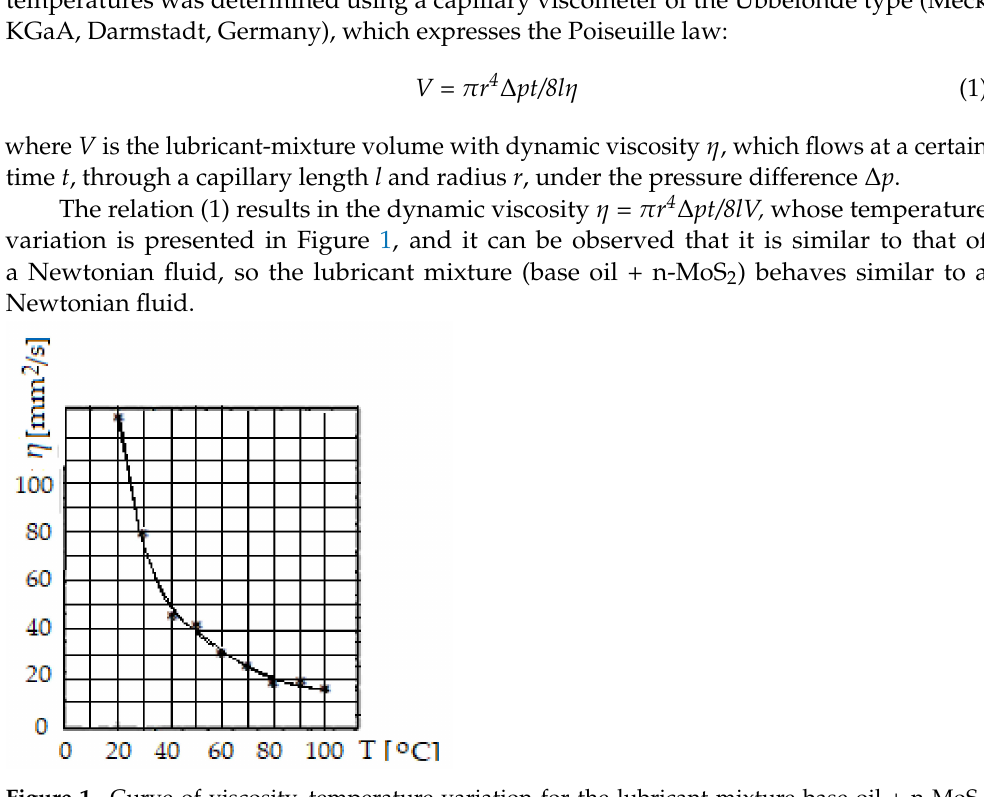
Figure 1. Curve of viscosity–temperature variation for the lubricant-mixture base oil + n-MoS 2 (MoS 2